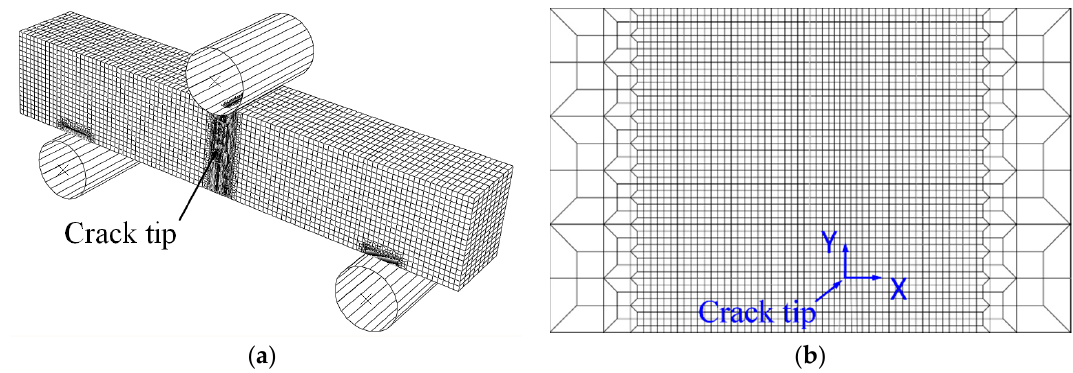
Figure 4. The whole meshes of the SENB specimen ( a ) and the local meshes along the crack growth region ( b ).